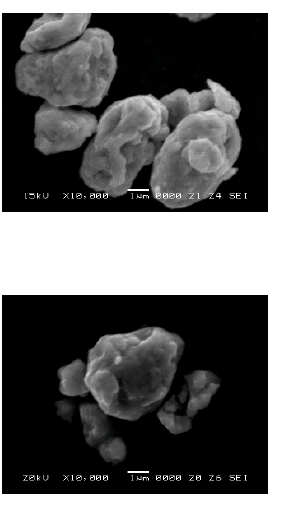
Figure 3. Chemical elements’ distribution maps, obtained by EDX analysis, of the samples milled for 2, 6, 10, and 15 h (10,000× magnification.)